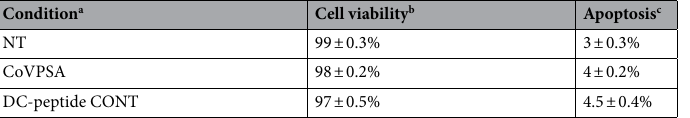
Table 3. Safety of DC vaccines loaded with COVID-19 peptides. a DC cells were incubated with 50 µg/mL of peptides for 16 hours. b Cell viability was explored after trypan blue staining and microscopy was used to count viable (non-stained) and non-viable (blue stained) cells. Results are expressed as the percentage of viable versus total cells (viable and non-viable cells). c Apoptosis is detected after DC staining with the DNA marker 7-AAD-PE and the apoptotic marker Annexin-V-APC. Results show the percentage of apoptotic cells ± SD of triplicate samples. All experiments were performed at least three times.